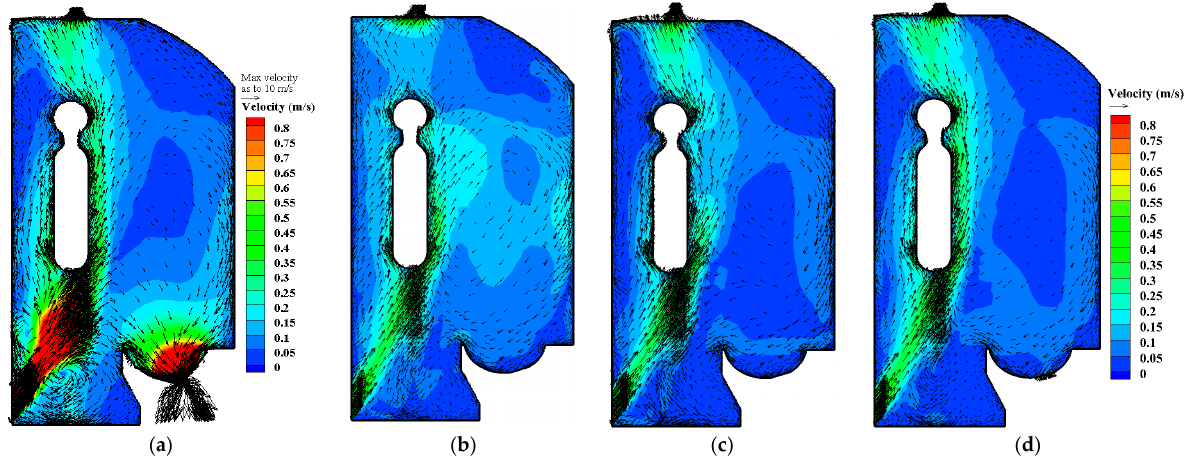
Figure 10. Time series of air distribution in the middle cross-section of the toilet for Case 2 at ( a ) 2 s; ( b ) 10 s; ( c ) 25 s; ( d ) steady state.